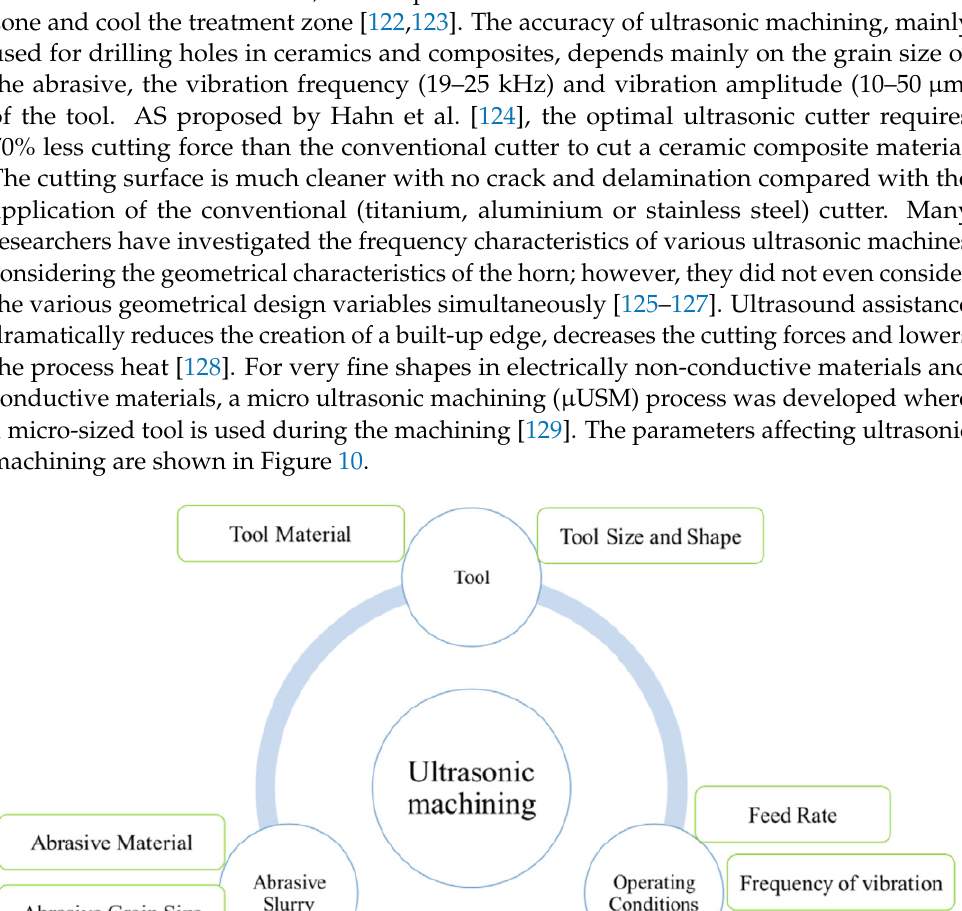
Figure 11. Illustrations of ( a ) RUM process and ( b ) RUEM processes (Reprinted with permission from Ref. [134], 2017, copyright Elsevier Ltd.). When cutting using Rotary Ultrasonic Surface Machining (RUSM), which combines both ultrasonic machining and surface machining processes, a cooling lubricant (liquid or cold air) is supplied to the machining area (Figure 12). For the first time, a comparison between RUSM and conventional surface grinding (CSG) of CFRPs and the effect of process parameters on surface roughness, torque and axial and infeed-directional cutting forces was conducted by Ning et al. [135]. It was found that RUSM exhibited larger surface